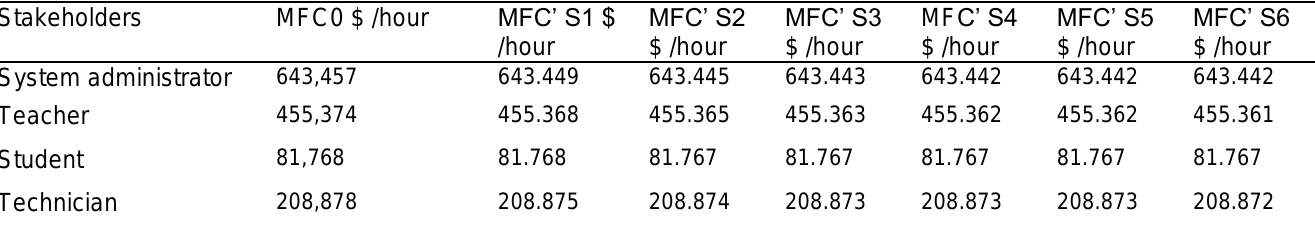
Table 12: MFC’Si application for e -learning systems for the web server